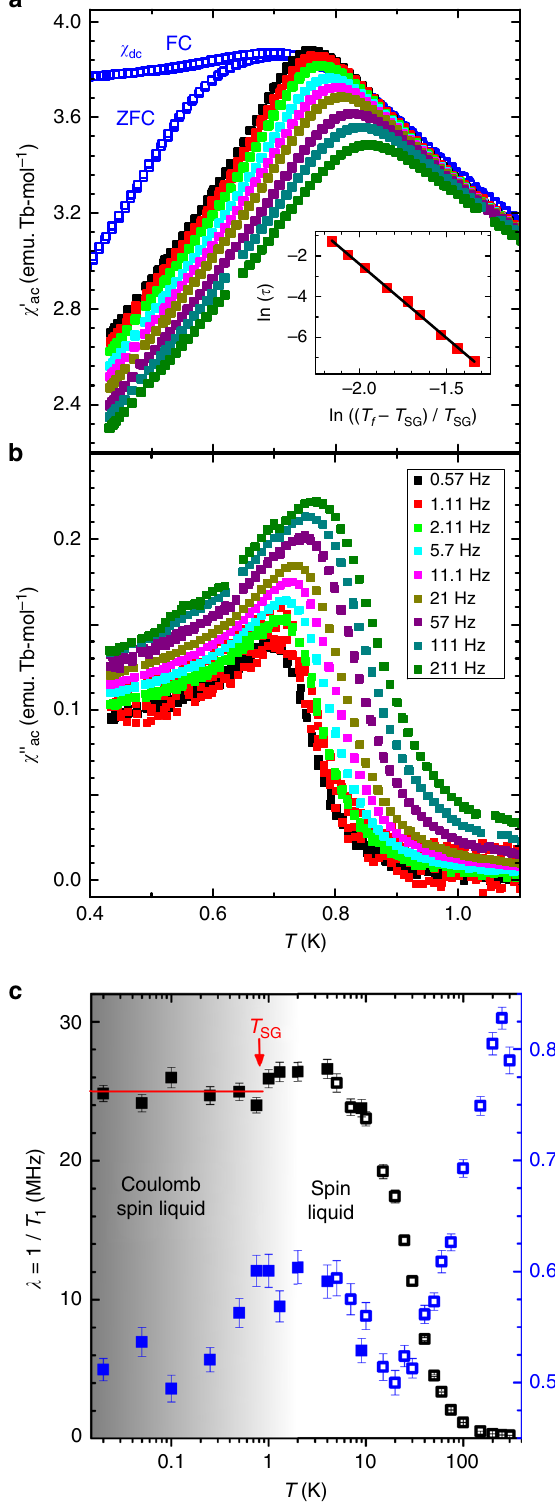
Fig. 4 Spin dynamics in Tb 2 Hf 2 O 7 probed by ac-susceptibility and muon spin relaxation. a , b Ac-susceptibility ( χ ac ) as a function of temperature. The real ( χ ′ ac ) and imaginary parts ( χ ′′ ac ) are shown for several frequencies f of the applied oscillating magnetic fi eld. In a , the blue open symbols represent the zero- fi eld cooled (ZFC) and fi eld-cooled (FC) dc susceptibility ( χ dc = M / H ) evaluated from the magnetization ( M ) measured as a function of temperature in a low fi eld ( H = 0.01 T). The inset in a shows ln( τ ) versus ln( t ), where τ = 2 π / f is the characteristic time and t = ( T f – T SG )/ T SG is the reduced temperature of the peak temperature T f in χ ′ ac at the frequency f , with T SG = 0.68 K the underlying spin-glass transition temperature. The black line is a fi t to the dynamical scaling law of spin glasses τ = τ 0 × t − z ν , where τ 0 = 4.1 ± 0.4 × 10 − 8 s is the shortest